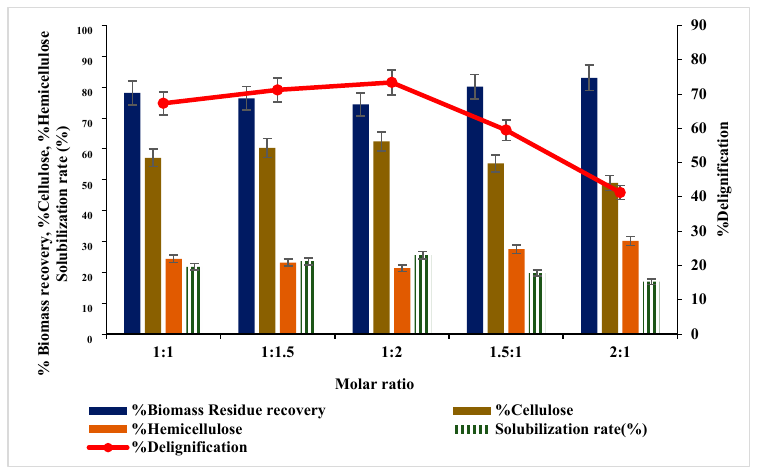
Figure 1. E ff ect of di ff erent molar ratios of ChCl: LA on deligni fi cation of Atriplex crassifolia . Figure 1. Effect of different molar ratios of ChCl: LA on delignification of Atriplex crassifolia .